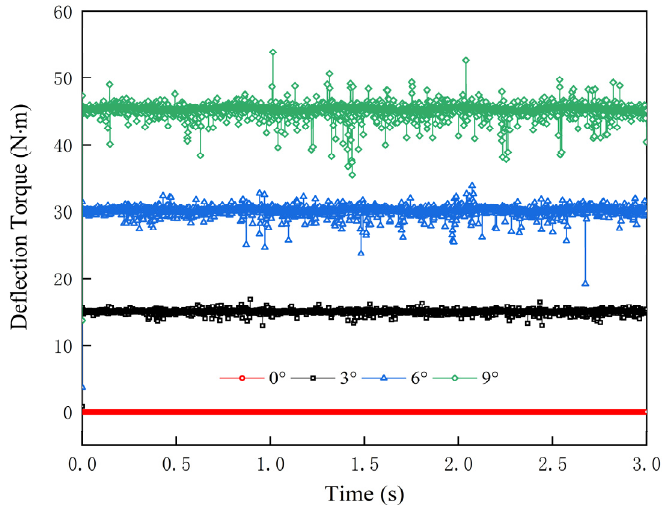
Figure 15. Curve of deflection moment with time at working angles of 0°, 3°, 6°, and 9°.